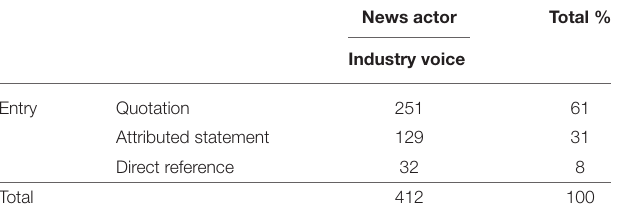
TABLE 3 | Industry voices by news